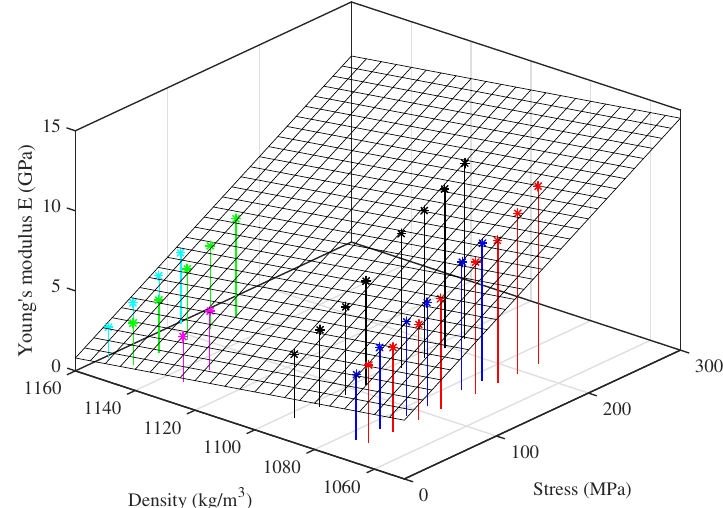
Figure 11. Young’s modulus from tension modulation at the base temperature of 20 ◦ C plotted as a function of stress and unstretched string density. Colours identify the di ff erent tested strings (Table 1): black (8:A6), red (14:A5), blue (5:A4), green (23a:A3), cyan (29:E3), magenta